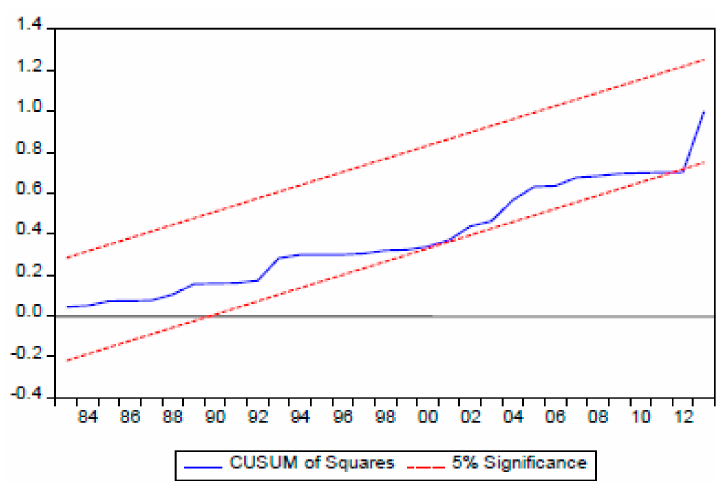
Figure 10. Plot of cumulative sum of squares recursive residuals for